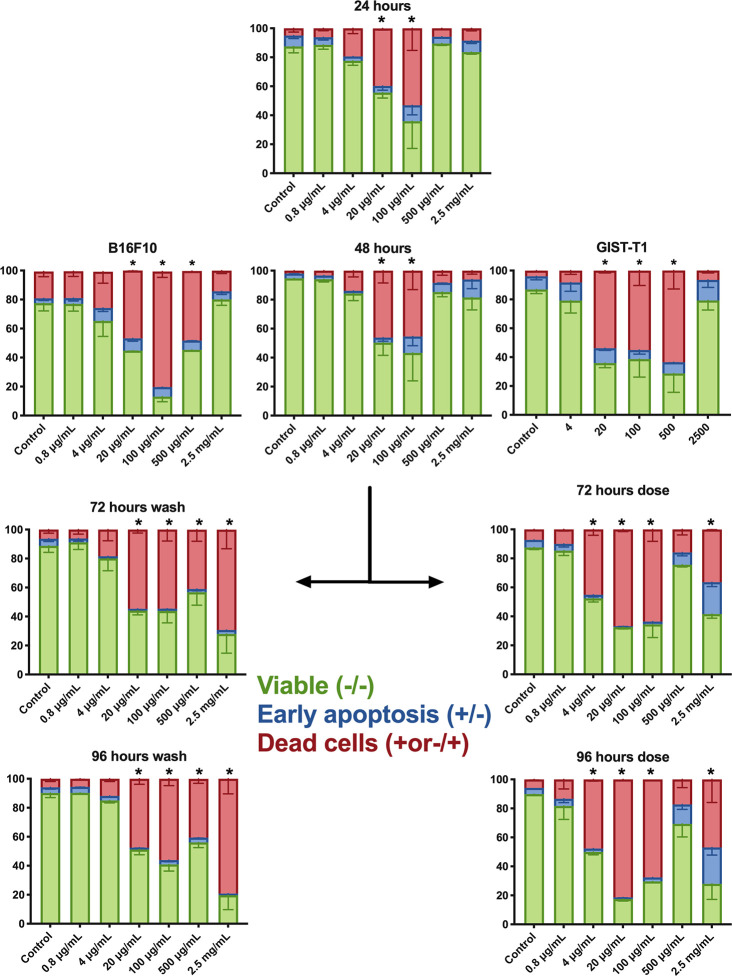
Flow cytometry annexin V/7-AAD (A375 and B.16.F10) or propidium iodide (PI) assay (GIST-T1). This depicts the distribution of cells within respective population at different concentrations; each graph represents a different time point. At 48 h, all three cell lines are shown: B16.F10, A375, and GIST-T1, the rest of the data presented in the figure is from culture with A375. After 48 h, a dose or wash protocol was done. Bars denoted with * had significantly fewer viable cells (double negative) and an increased cell population of 7-AAD+ cells. The cells receiving a second dose of polyvinyl alcohol carbazate (PVAC) at a concentration of 2.5 mg/ml also had an increased number of early apoptotic cells (Annexin V+/7-AAD−). For representative examples of flow cytometry and gating, see
Supplementary Figure A
. D, dose; W, wash. n = 3 (biological replicates). * denotes p-value < 0.05.